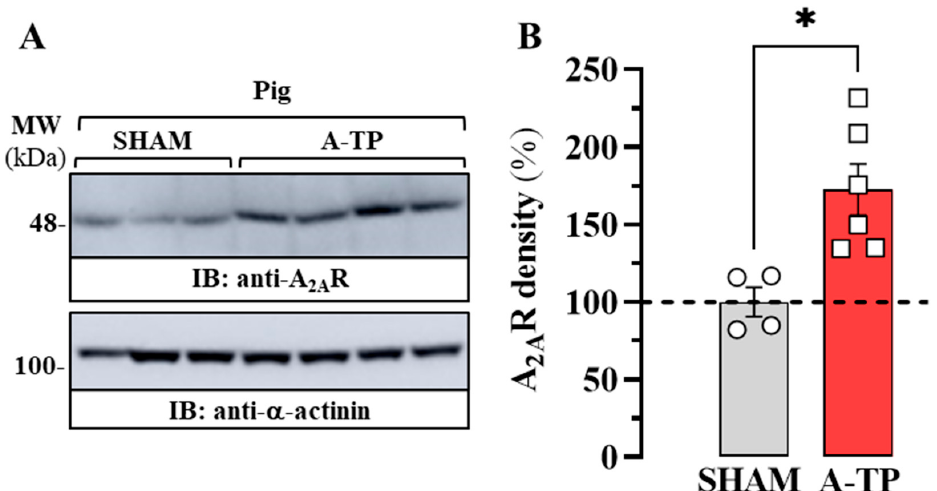
Figure 4. Expression of A 2A R in the atrium of the porcine model of AF. ( A ) Representative im- munoblot showing the density of A 2A R in the right atrium of control (SHAM, circles) and tachypaced (A-TP, squares) pigs. The atrial membrane extract of SHAM and A-TP pigs was analysed by SDS- PAGE (10 µ g of protein/lane) and immunoblotted using mouse anti-A 2A R and rabbit anti- α -actinin antibodies (see Methods). ( B ) Relative quantification of A 2A R density. The immunoblot protein bands corresponding to A 2A R and α -actinin from SHAM ( n = 4) and A-TP pigs ( n = 6) were quantified by densitometric scanning. Values were normalized to the respective amount of α -actinin in each lane to correct for protein loading. The results are shown as percentages of the relative density of A 2A R in SHAM pigs (dashed lane) and expressed as mean ± SEM. * p < 0.05, Student’s t